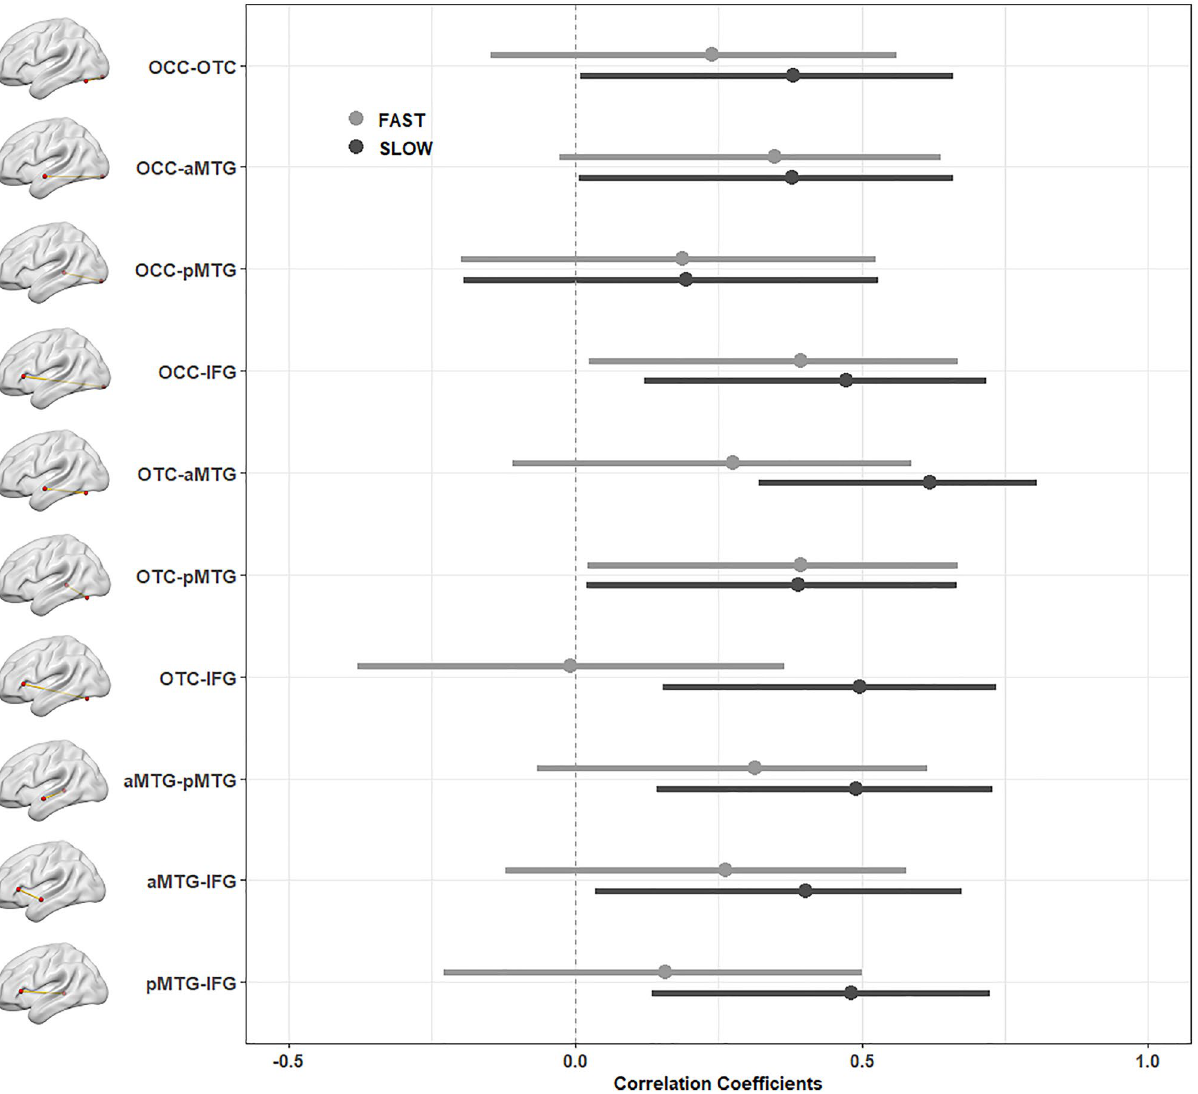
Figure 4. Correlation coefficients (with 95% confidence intervals) for all connections among our ROI-to-ROI analysis for fast (light grey) and slow (dark grey)